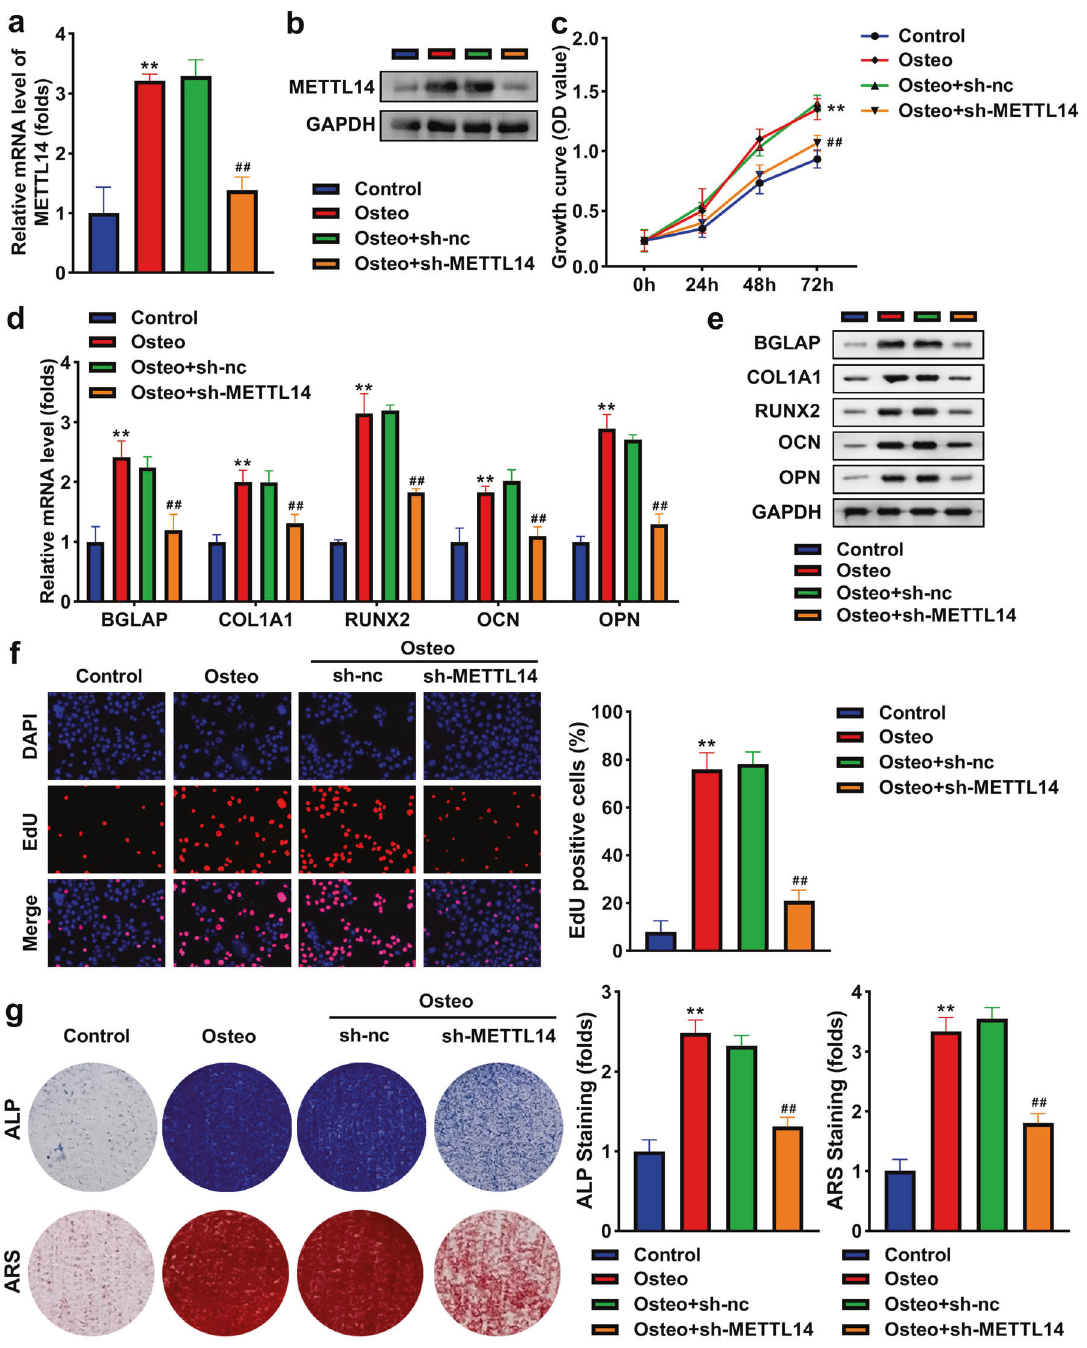
Fig. 3 Knockdown of METTL14 inhibits osteogenic differentiation. METTL14 in osteogenic BMSCs following transfection was examined by a qRT-PCR and b western blot. c Cell growth was assessed using the CCK-8 assay. d The mRNA expression of BGLAP, COL1A1, RUNX2, OCN, and OPN. e The protein levels of BGLAP, COL1A1, RUNX2, OCN, and OPN. f Cell proliferation was assessed using EDU assay. g Osteogenesis was analyzed using ALP staining assay and ARS staining assay. The staining intensity was quanti fi ed. ** P < 0.01 vs. control. ## P < 0.01 vs. osteo +